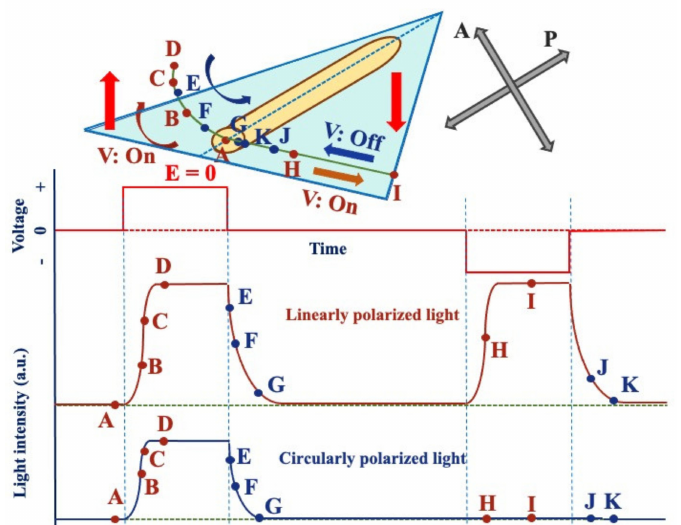
Figure 18. Liquid crystal molecular director switching model for the heavily twisted stacked SSD-LC panel. In the heavily twisted stacked SSD-LC panel, the liquid crystal molecular director switch is asymmetric. The molecule lifts up only when a positive pulse voltage is applied, and for a negative pulse voltage, the molecule stays at the same plane as the initial aligned plane.